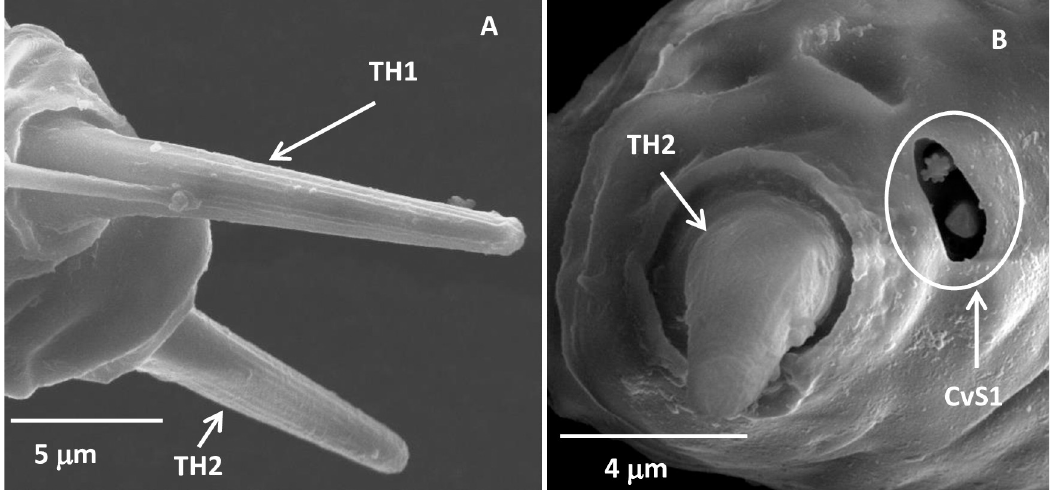
Fig 2. The antennal tip of the third-instar Diaphorina citri nymphs. (A) Two terminal hairs and sensilla trichoidea. (B) The short terminal hair and cavity sensillum 1. TH1, the long terminal hair; TH2, the short terminal hair; CvS1, cavity sensillum 1.